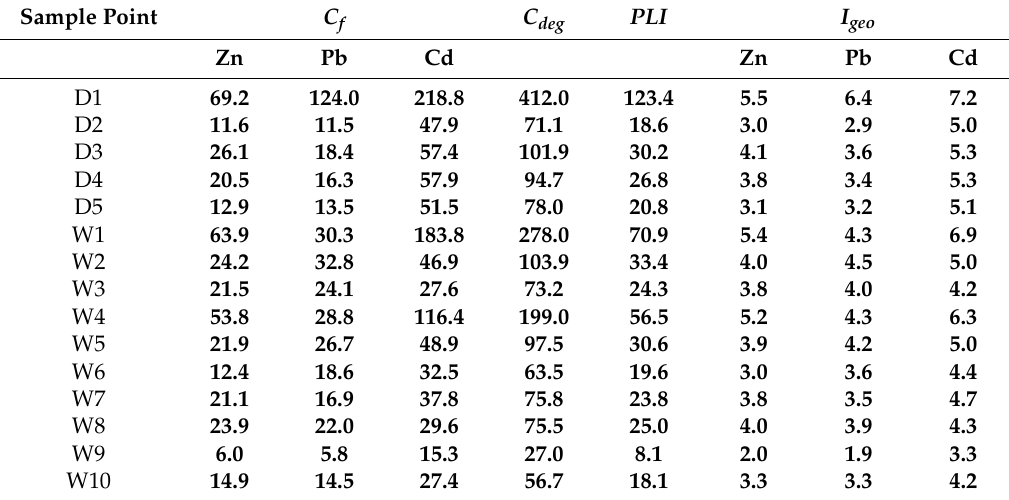
Table 8. Assessment of HM pollution indices in studied topsoil in relation to the median for European topsoil as a background value